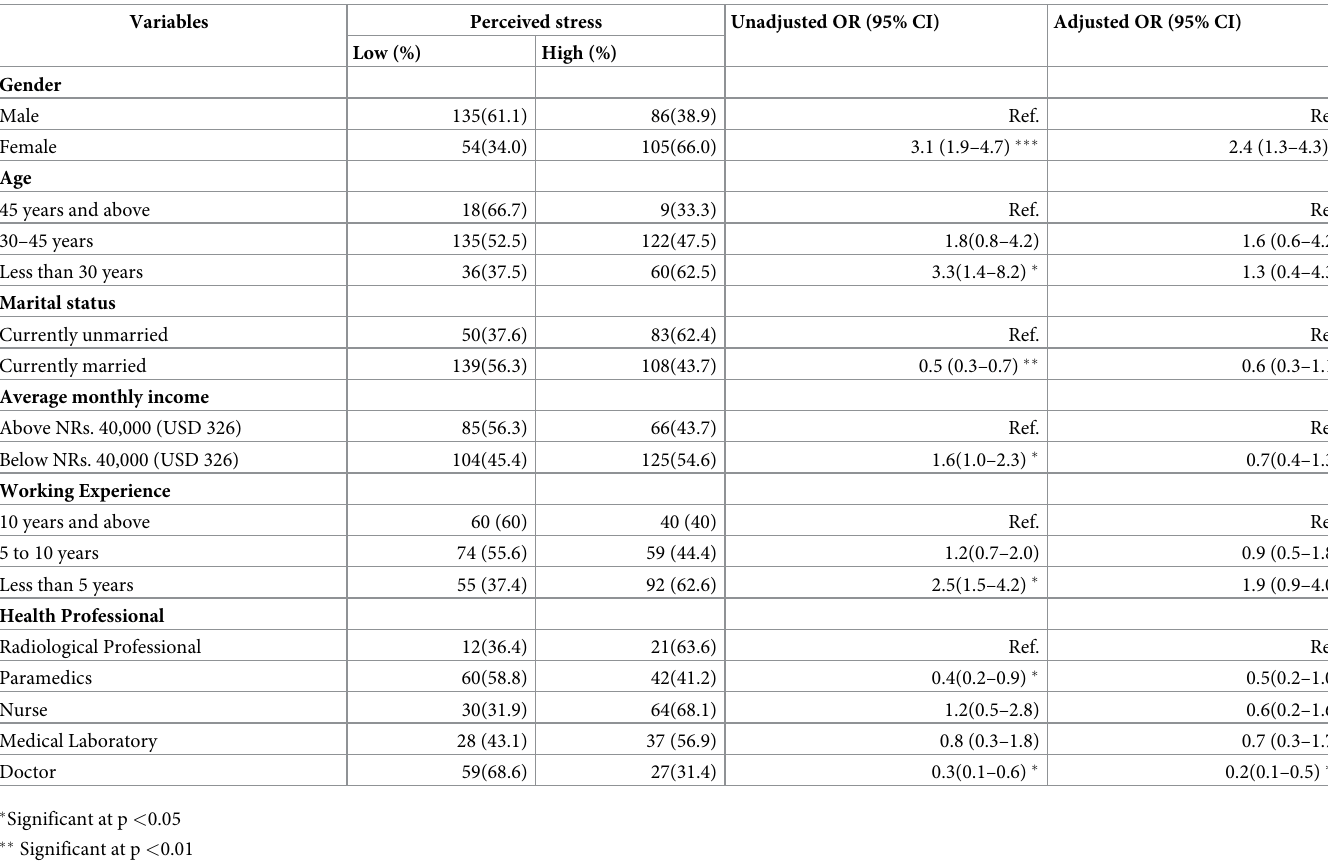
Table 4. Association of perceived stress with independents